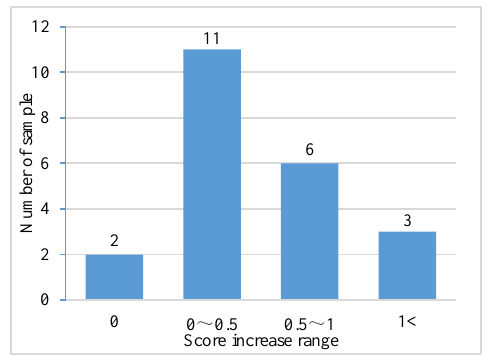
Figure 11. The statistical results of 20 samples.